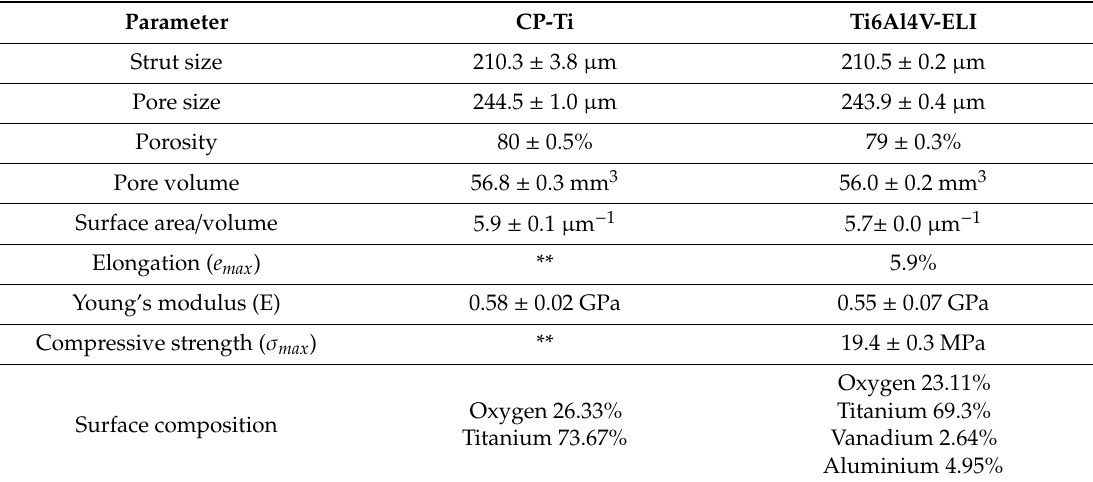
Table 1. Properties of CP-Ti and Ti6Al4V-ELI porous titanium implants.